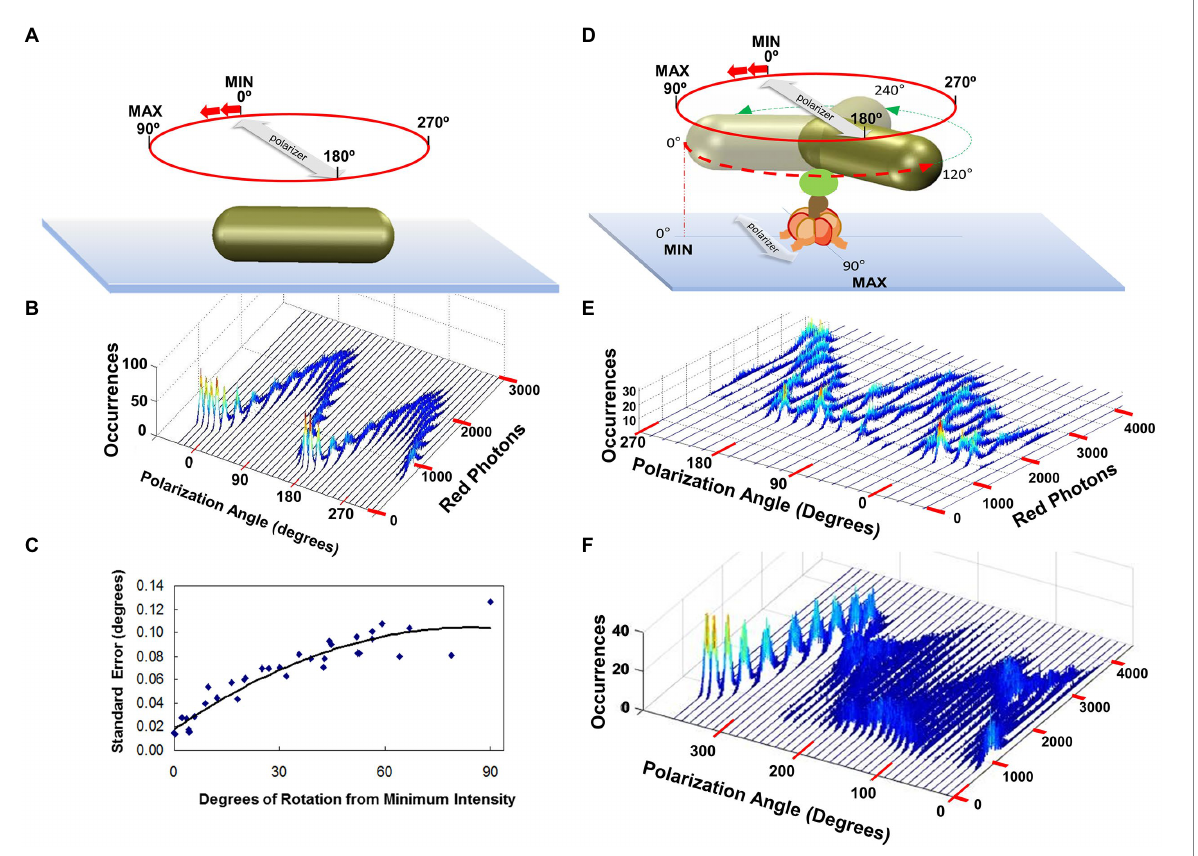
FIGURE 6 Polarizer Rotation Measurements (PRM) to determine rotational position measurement error and to show F 1 -ATPase-dependent 120 ° step rotations. (A) PRM measurement of a nonrotating AuNR attached directly to the cover slip. Red photons scattered from the AuNR were measured in 5 s intervals at a data sampling rate of 1 kHz (1,000 fps) at each 10 ° stepped rotational position of the polarizer. (B) PRM-dependent distribution of photons scattered from the non-rotating AuNR of A vs. rotary position of the polarizer. (C) Standard error of the AuNR rotary position vs. degrees of rotation from the minimum intensity calculated from B . This error is equivalent to that obtained from a data set of 3,250 power strokes. (D) PRM measurement of a AuNR attached to an actively rotating subunit- γ of the F 1 -ATPase in the presence of saturating ATP concentrations. (E) PRM- dependent distribution of photons scattered from the non-rotating AuNR of A vs. rotary position of the polarizer. (F) PRM when the AuNR is attached to actively rotating F 1 subunit- γ , which stops rotating at polarizer angle 260 ° , likely due to subunit- ε inhibition. This figure was reconfigured from Spetzler et al. (2006), Ishmukhametov et al. (2010), Sielaff et al.